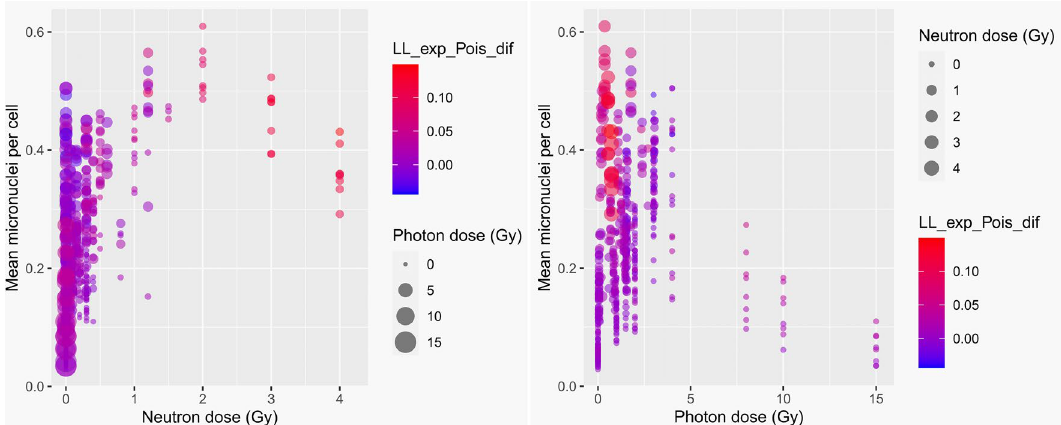
Figure 4. Visualization of how micronuclei per binucleated cell probability distribution shapes systematically differ after photon and neutrons exposures. Each circle represents a blood sample. The left and right panels show the same data set, but focus on different variables. LL_exp_Pois_dif (described in Table 1) is one of the predictors used in the machine learning